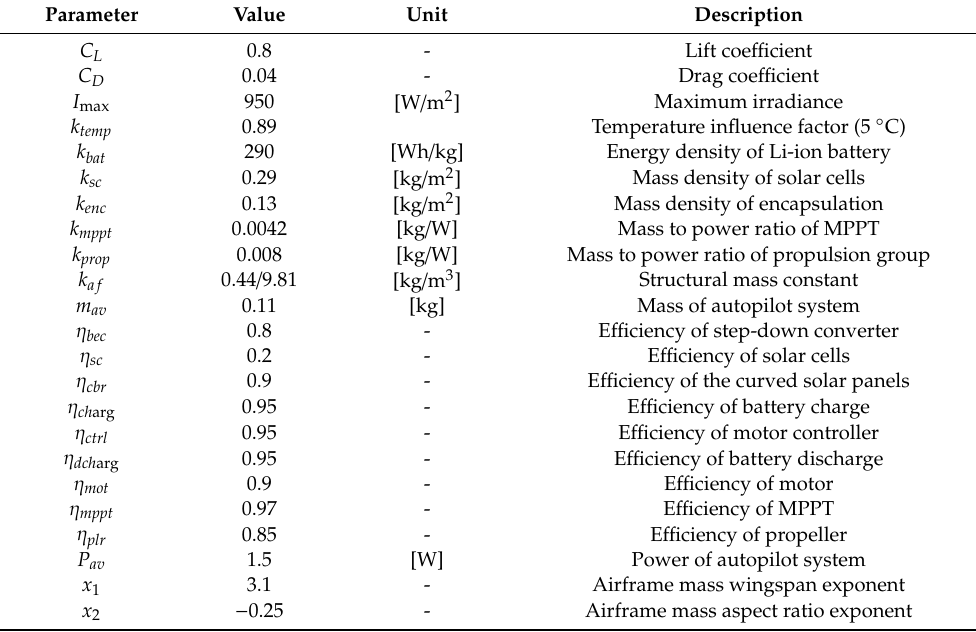
Table 1. The values of parameters correspond to the Mini-Phantom UAV design. Parameter